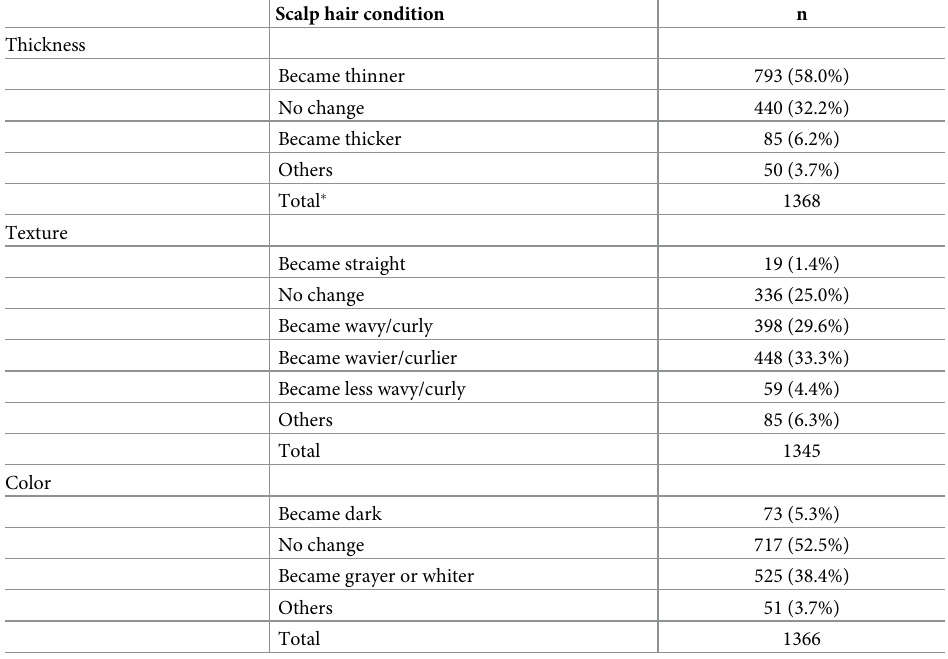
Table 4. Condition of the scalp hair 6 months after the beginning of hair